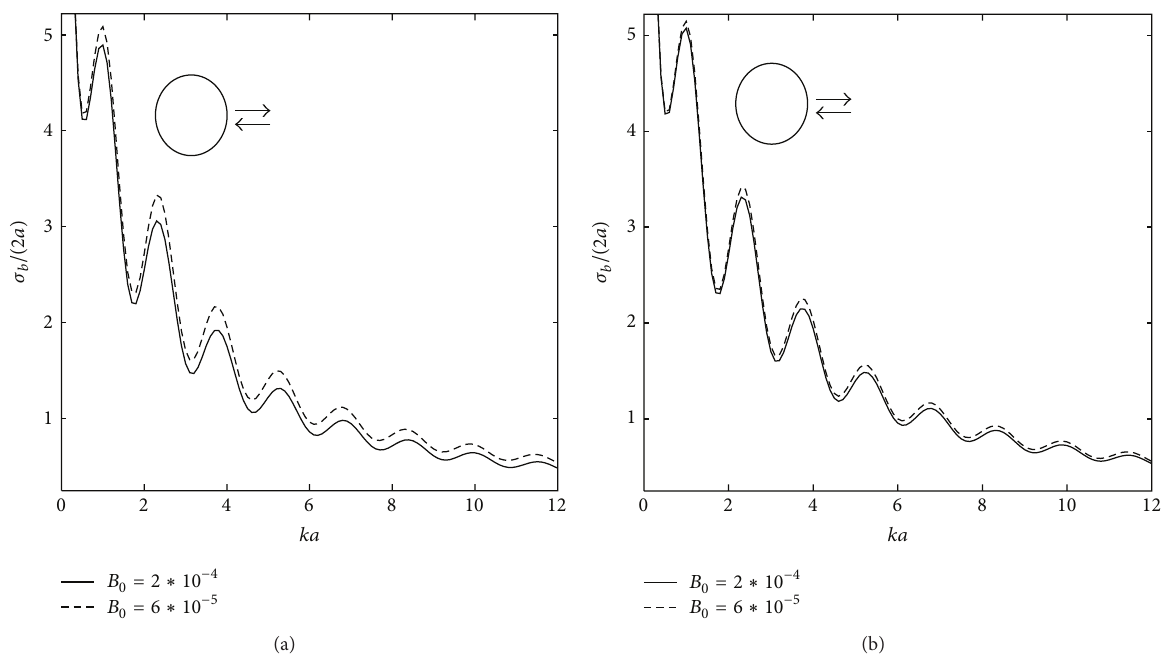
Figure 3: LRCS versus target size for 𝛿 = 0 and 𝑘𝑊 = 1.5 where the target is located in random medium with (a) SCL = 3, (b) SCL =